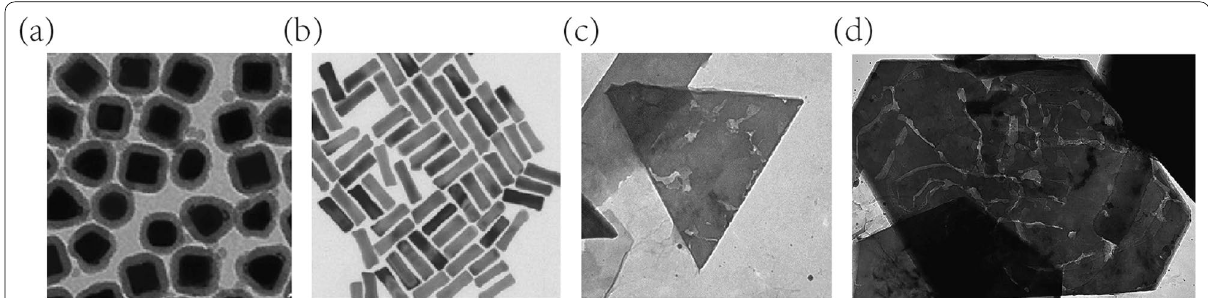
Fig. 5 The TEM images of gold nanoparticles with cage-like ( a ), cylindrical ( b ), triangular ( c ) and hexagonal ( d ) morphologies. Referred from [112–114] with permission